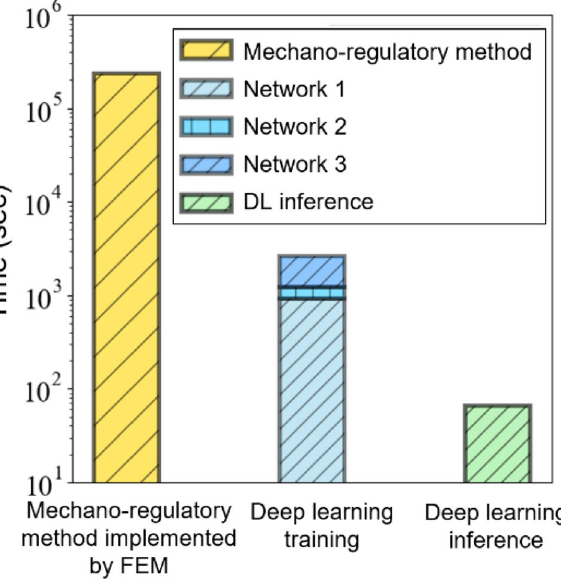
Figure 6. The comparison of computational resource consumption between mechano-regulatory method implemented by FEM and